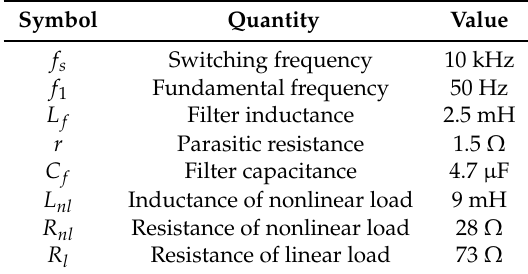
Table 1. Circuit